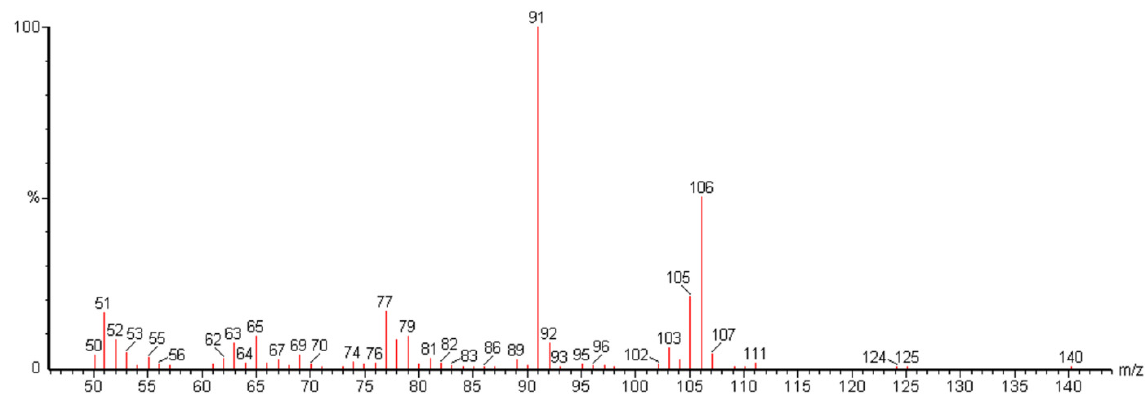
Figure 6. MS spectrum for the peak with a retention time of 12.89 min.